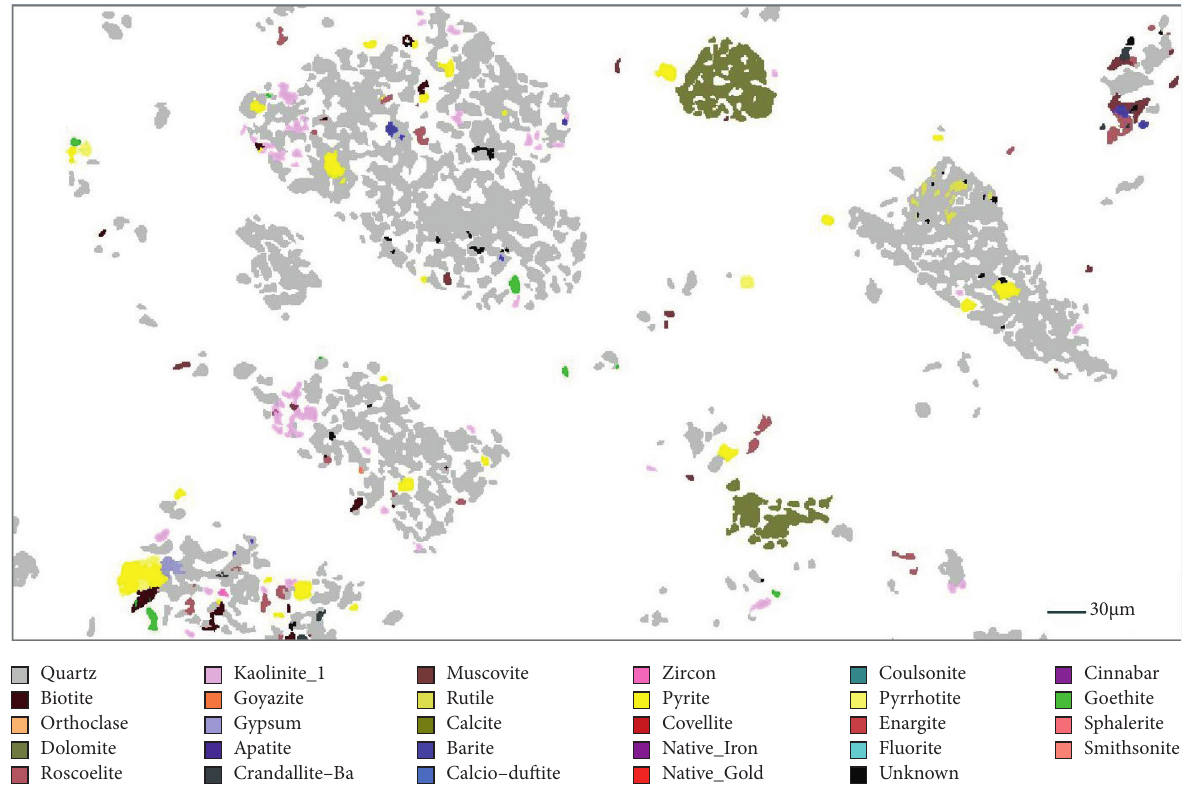
Figure 1: MLA images of the raw